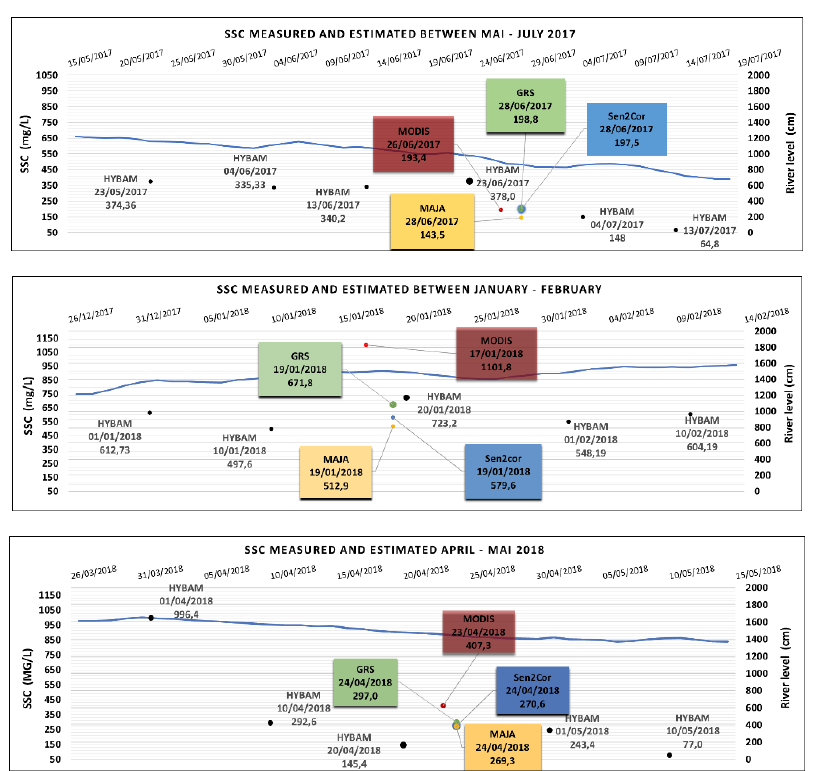
Figure 4a, 4b e 4c – SSC measured and estimated in tree distinct hydrological periods